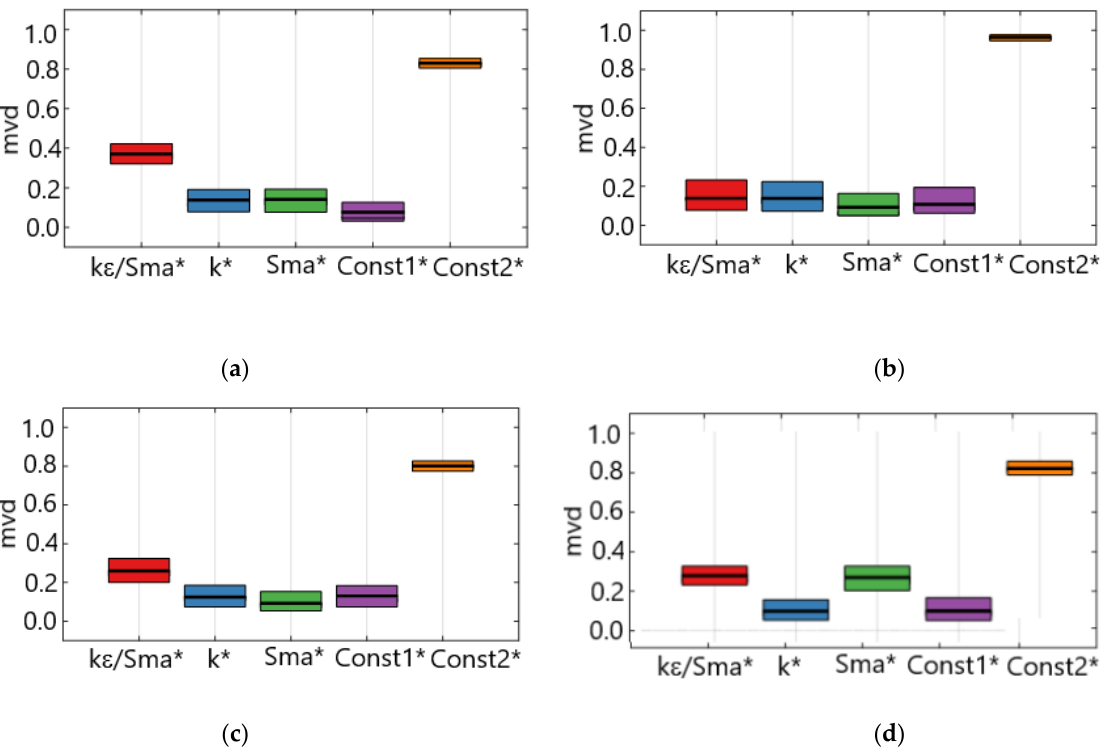
Figure 9. Mvd ( a ) index for the eddy viscosity ( ν T ), for St1 ( a ), St2 ( b ) St4 ( c ) and St6 ( d ).